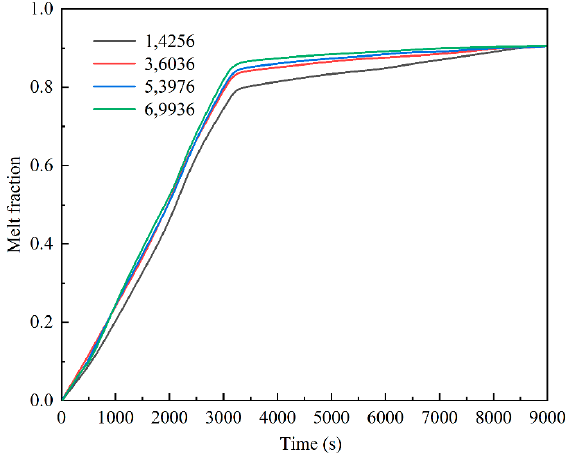
Figure 3. Grid-independence verification.